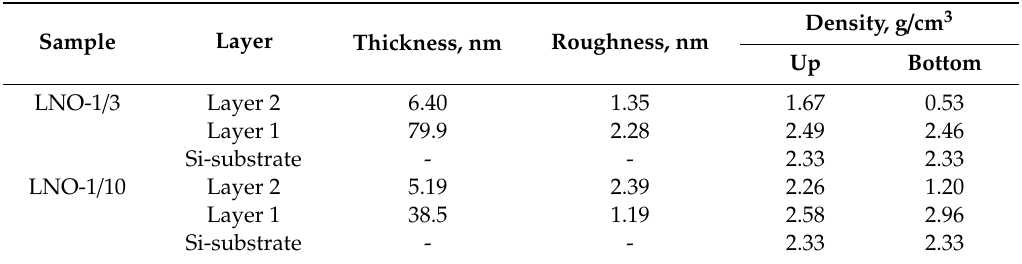
Table 3. Results of X-ray reflectometry (XRR) curves modeling and fitting for LNO samples.